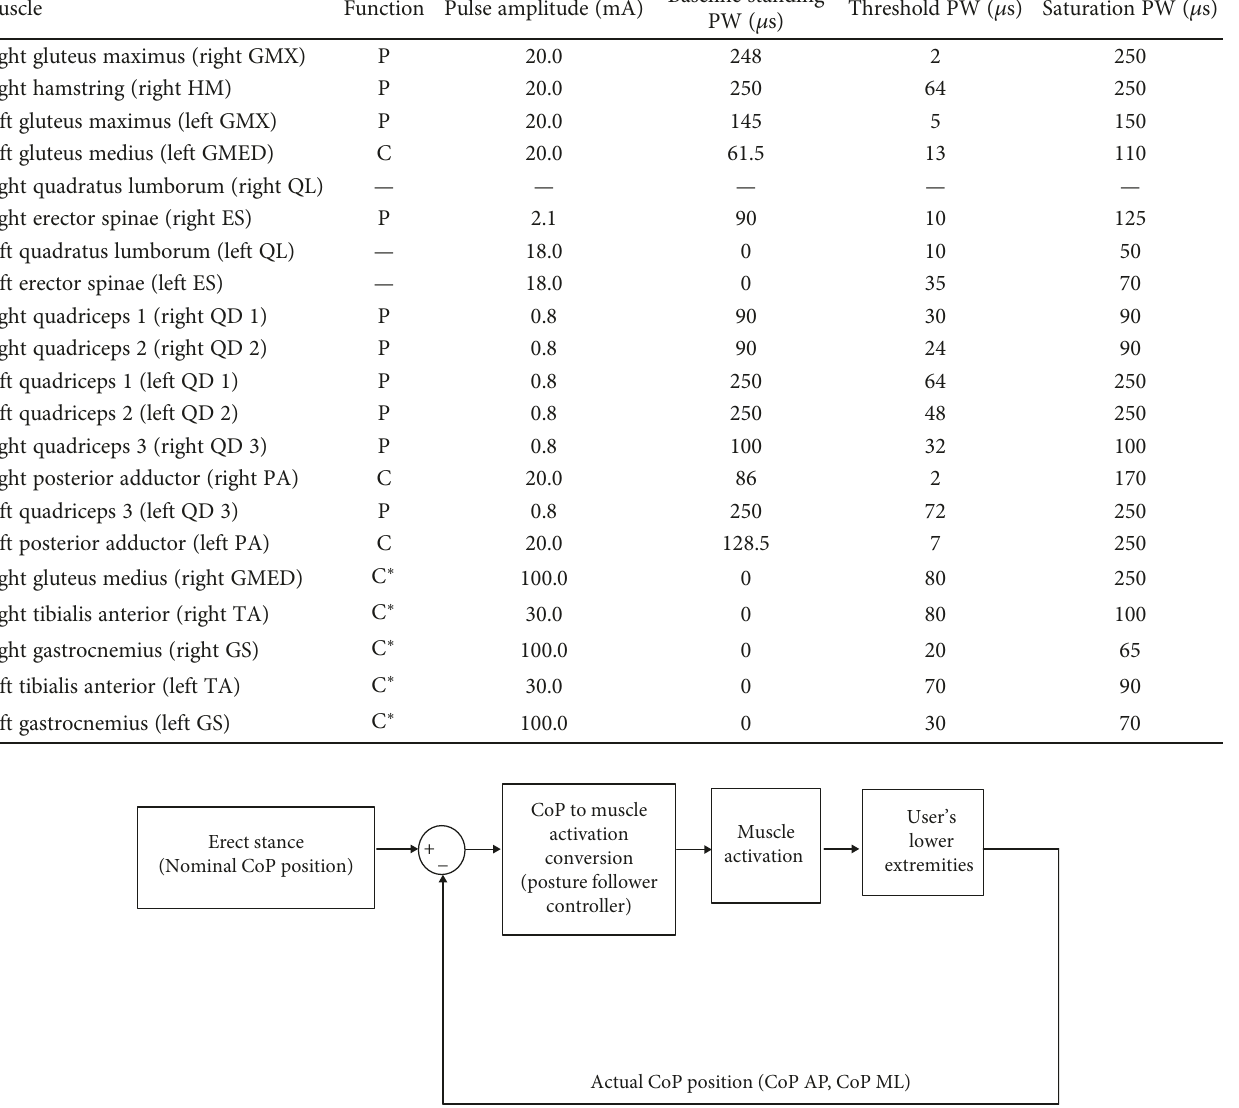
Figure 1: Control setup. The user stands erect on force plates, which measure the center of pressure (CoP) position in the anterior-posterior (AP) and medial-lateral (ML) directions. The user leans away from the erect stance, adjusting the overall CoP position towards the ends of the paths in the forward and diagonal directions. The force plates continuously track the resulting changes in the CoP position and the posture follower controller converts the changes in the CoP position to muscle activation, which is applied to the lower